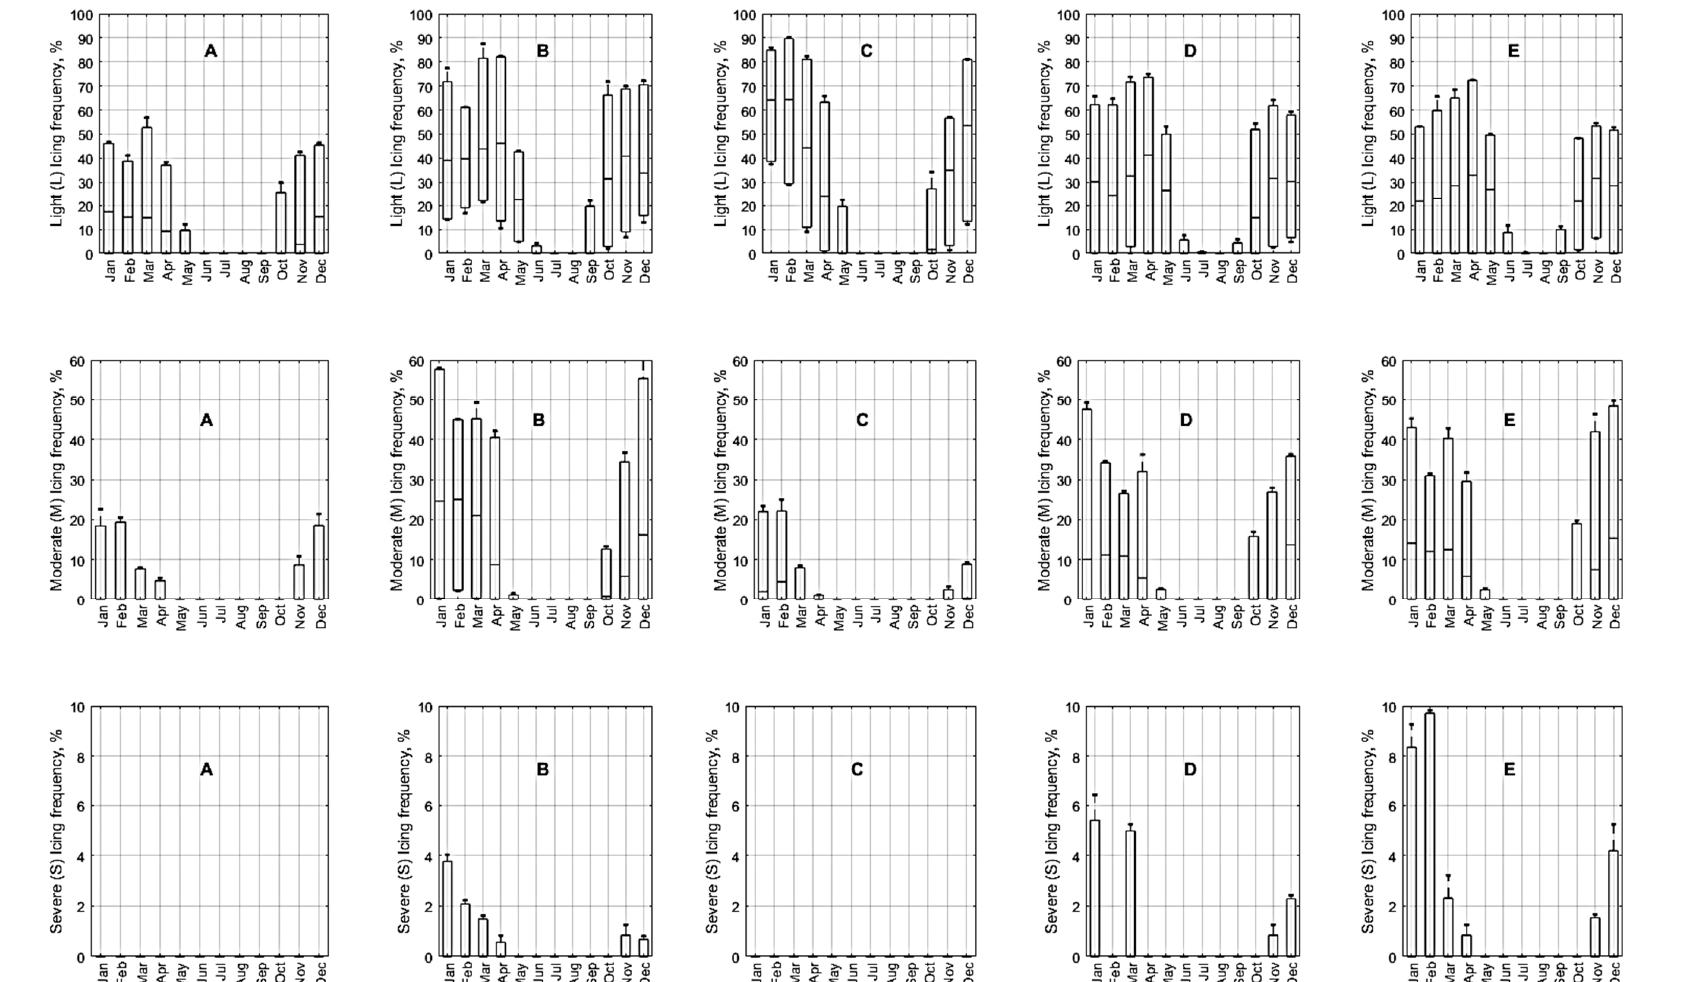
Figure 6. Box plot (minimum, 2.5th, 50th, and 97.5th percentiles, and maximum) of 3-hourly icing frequency for each location in each month corresponding to light icing (first row), moderate icing (second row), and severe icing (third row).